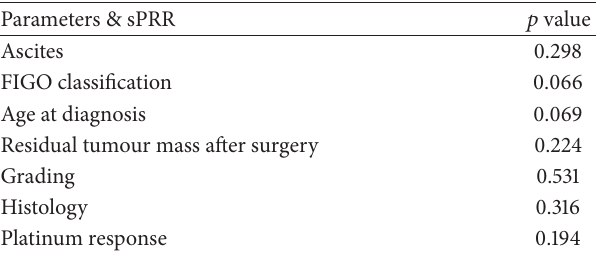
Table 3: 𝑝 value and Spearman’s rank for the